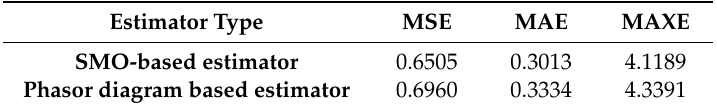
Table 5. Performance indices of the SMO-based estimator and the phasor diagram based estimator during dynamic disturbances of reactive power for generator operating point P = 0.89, Q = 0.11 cap.